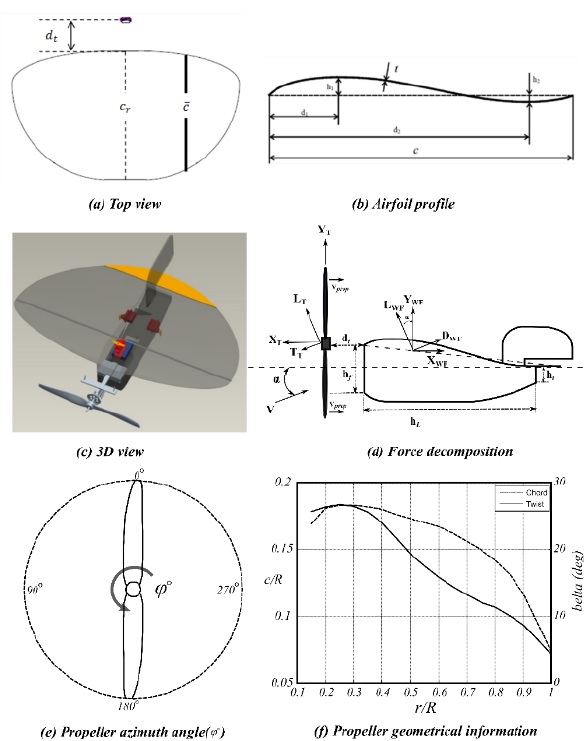
Figure 3. MAV and propeller geometrical descriptions, ( a ) Mav in top view, ( b ) airfoil profile, ( c ) MAV in 3D view, ( d ) aerodynamic force decomposition, ( e ) propeller azimuth angle, and ( f ) propeller geometrical information(chord and pitch angle distribution). Table 2. Propeller location and fuselage